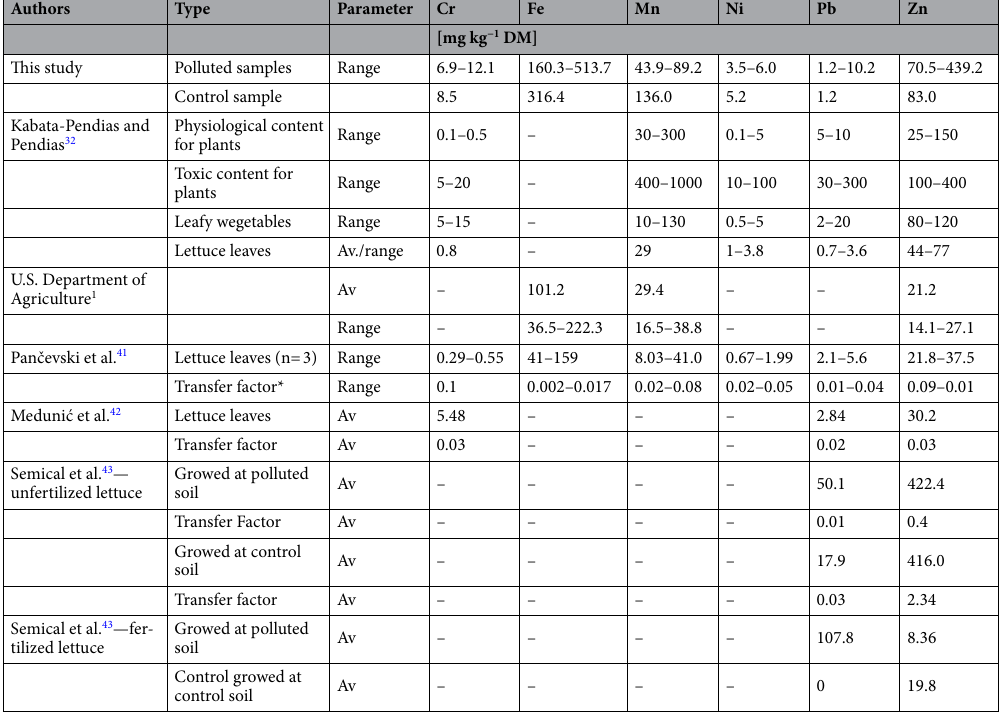
Table 4. The content of microelements in lettuce leaves—a literature review.